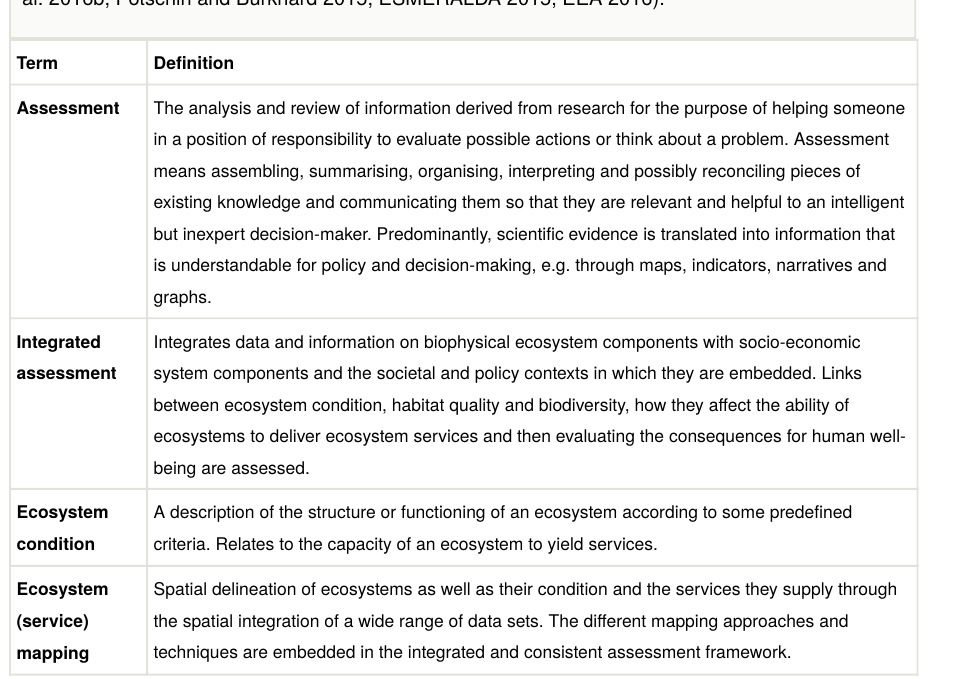
De fi nitions for terms used in the framework (based on Maes et al. 2016a, Maes et al. 2013, Maes et al. 2016b, Potschin and Burkhard 2015, ESMERALDA 2015, EEA